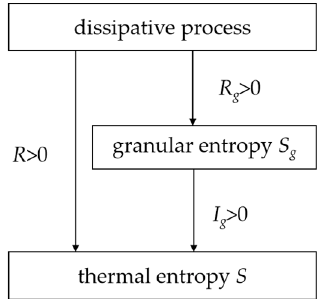
Figure 1. The two-stage irreversible dissipation processes of the granular system.